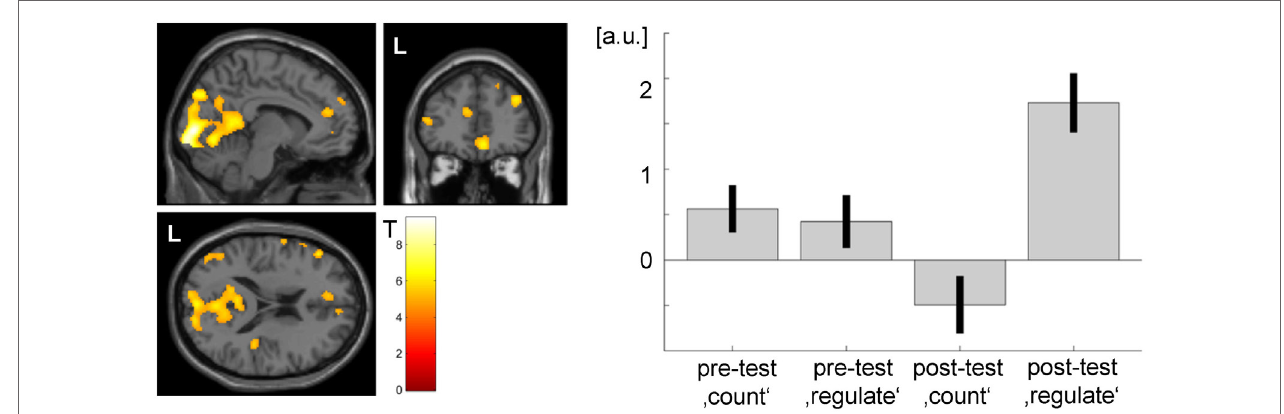
FIGURe 7 | transfer effect in patient 2 ( p < 0.05, FWe corrected) . ACC regulation emerged also in the absence of feedback after the NF training as compared to before. However, the ACC activation cluster was noticeably smaller than during the neurofeedback training (see Figure 3 ) and did not yield significance in patient 1. The strong activation changes in the visual system may be related to attention shifts with respect to the visual